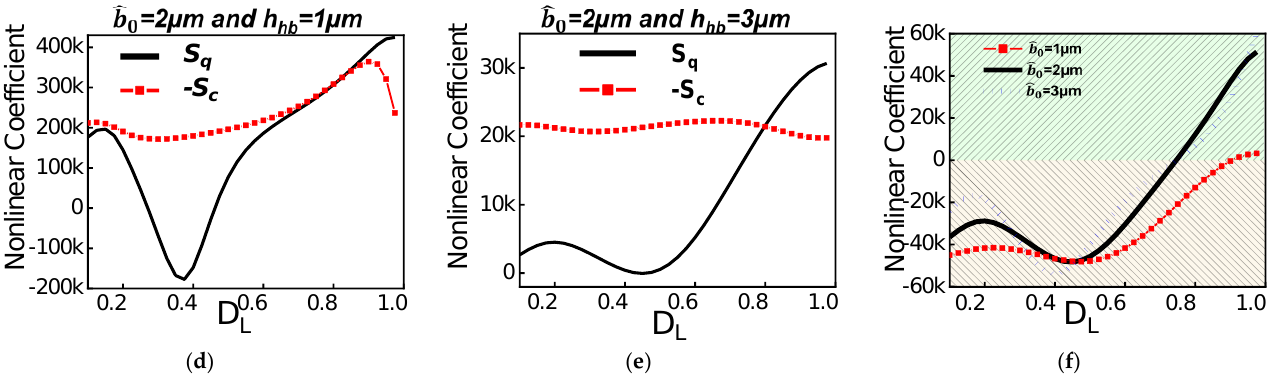
Figure 2. Variation of cubic (dashed) and quadratic (solid) nonlinearity coefficients of the proposed hybrid curved beam with dome length. ( a ) ˆ b 0 = 1 µ m and h = 2 µ m ( b ) ˆ b 0 = 2 µ m and h hb = 2 µ m ( c ) ˆ b 0 = 3 µ m and h hb = 2 µ m ( d ) ˆ b 0 = 2 µ m and h hb = 1 µ m ( e ) ˆ b 0 = 2 µ m and h hb = 3 µ m. ( f ) the total effective nonlinearity for h hb = 2 µ m at different initial rises. The D L axis starts from 0.1.